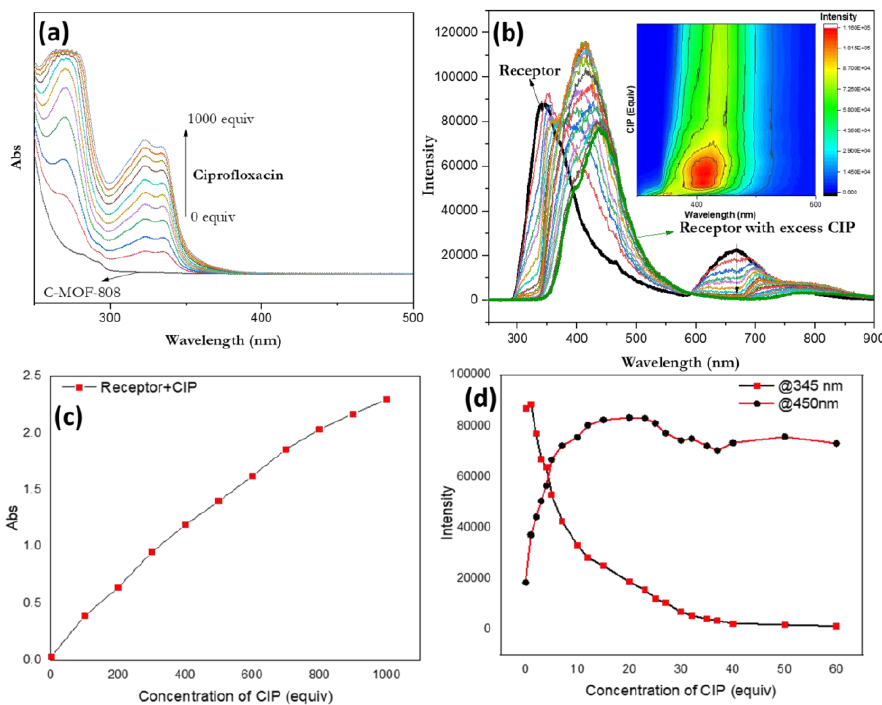
Figure 8. The changes in ( a ) the absorption and ( b ) emission spectra of the receptor at pH 6.9 upon titration with CIP ( λ ex = 310 nm; inset: contour plot). The absorbance ( c ) and emission ( d ) intensities of the receptor as a function of the equivalents of CIP added.